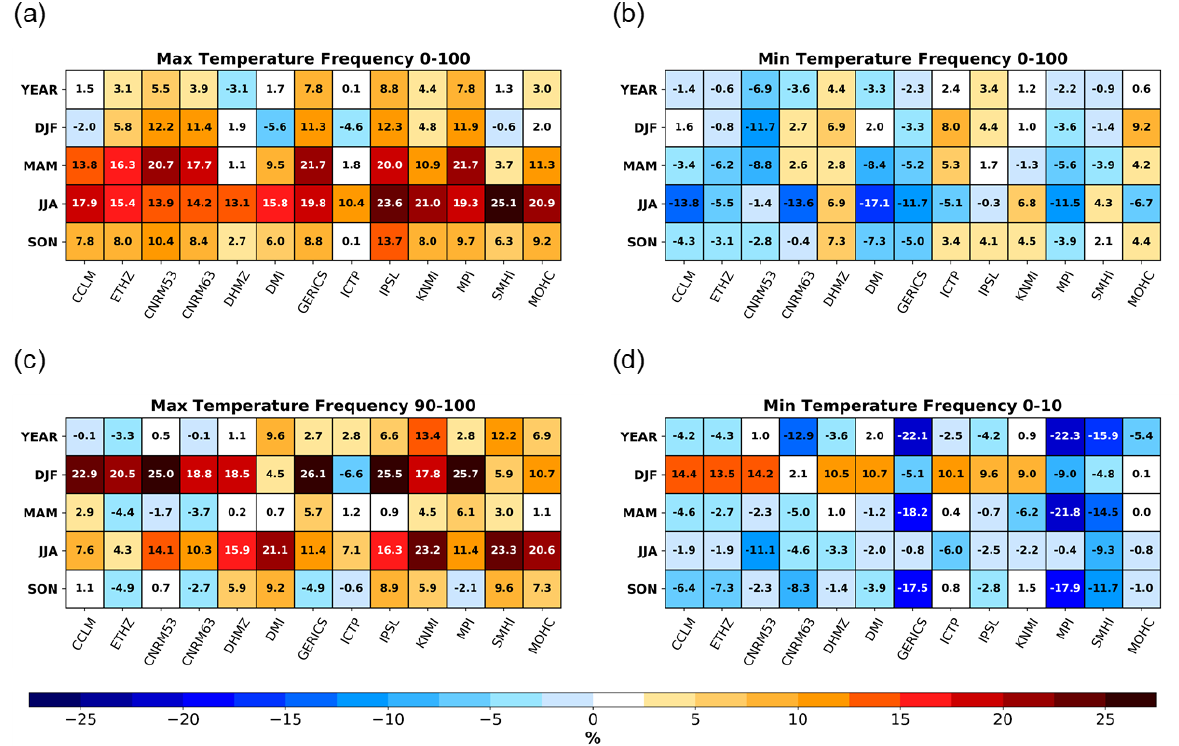
Figure 2. Yearly and seasonal distribution added values (DAVs) of the Iberian Peninsula between the RCMs and the ERA-Interim reanalysis for the 1989–2008 period taken from the hindcast EURO-CORDEX simulations, with the IGD regular dataset as a reference for (a) maximum daily temperature considering the whole PDF, (b) minimum daily temperature considering the whole PDF, (c) maximum daily temperature extremes only considering the values above the observational 90th percentile from maximum temperatures, and (d) minimum temperature extremes only considering the values below the observational 10th percentile from minimum temperatures. All RCM data were previously interpolated to 0.1 ◦ regular resolution from the observations, while the observations were interpolated into the ERA-Interim